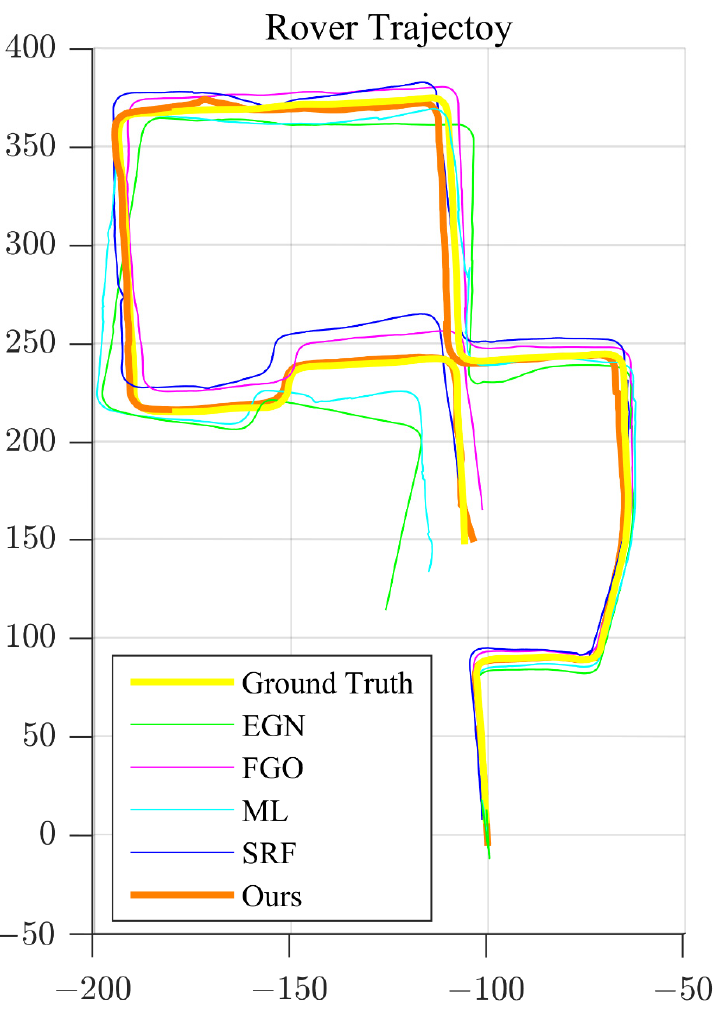
Figure 8. The determined trajectories of the planetary rover. The ground truth and our determined trajectories are bolded.